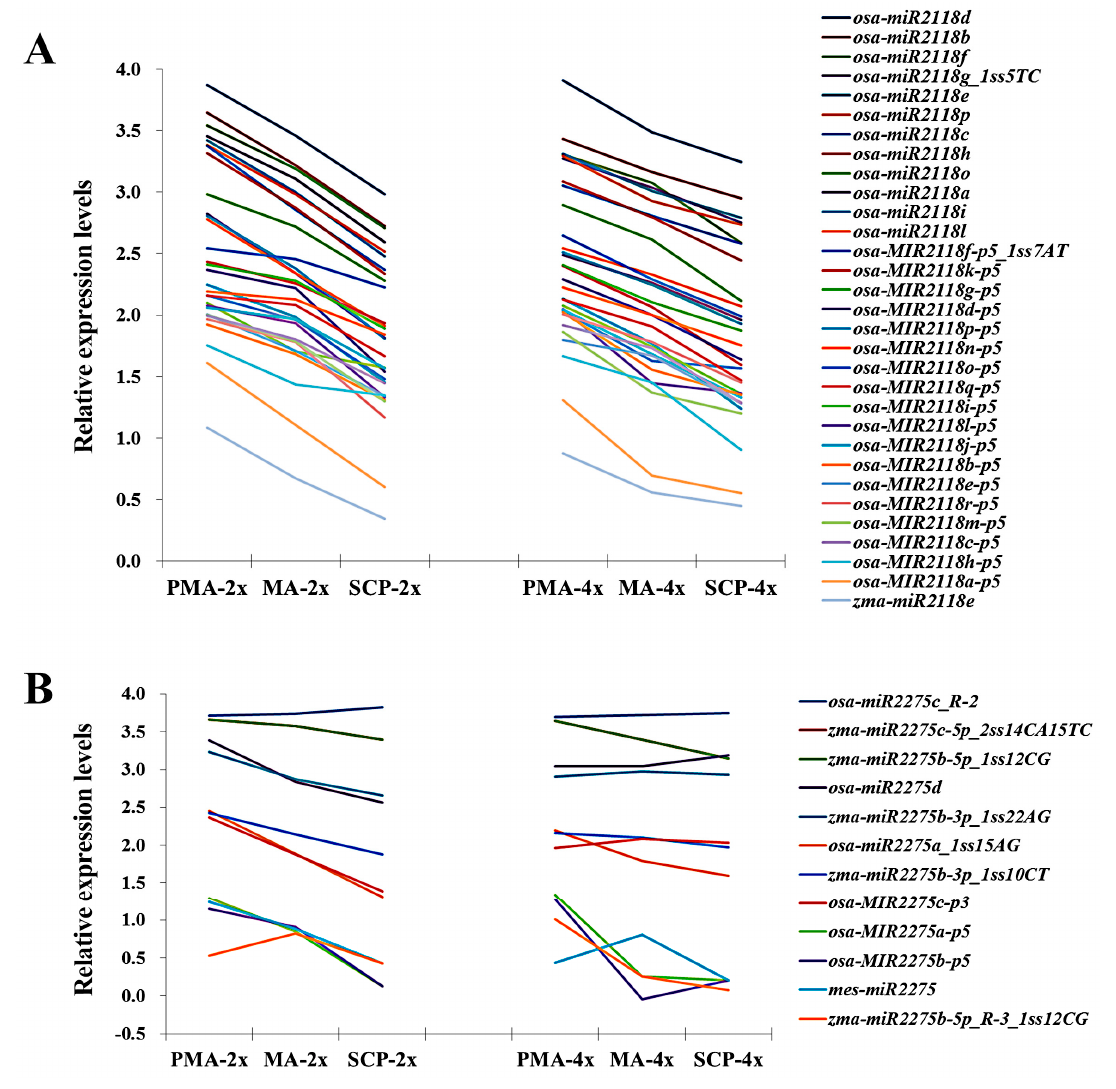
Figure 5. The relative expression levels of miR2118 ( A ) and miR2275 ( B ) families between Taichung65-4x and Taichung65-2x. PMA, MA and SCP represent pre-meiotic interphase, meiosis and single microspore stage, respectively. “4x” and “2x” represent the autotetraploid and diploid rice, respectively.